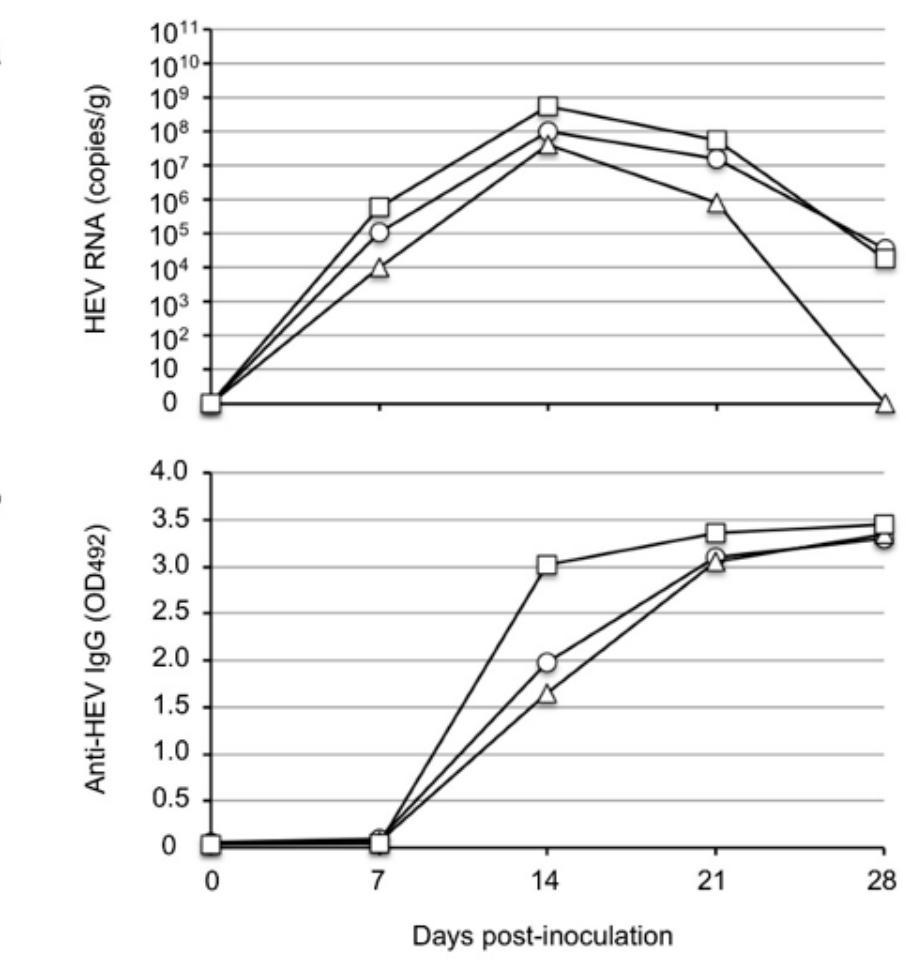
Figure 4. Infectivity of rat HEV recovered from the rhesus monkeys. Three SD rats, SD-1 ( ), SD ‐ 2 ( (cid:52) ), and SD-3 ( (cid:3) ), were intravenously inoculated with 0.5 mL of 10% stool suspension containing 4.8 × 10 4 copies/mL collected from monkey M097 on day 10 p.i. The virus RNAs in the fecal speci ‐ mens were detected by RT ‐ qPCR ( a ), and anti ‐ rat HEV IgG antibodies were detected by an ELISA ( b ).